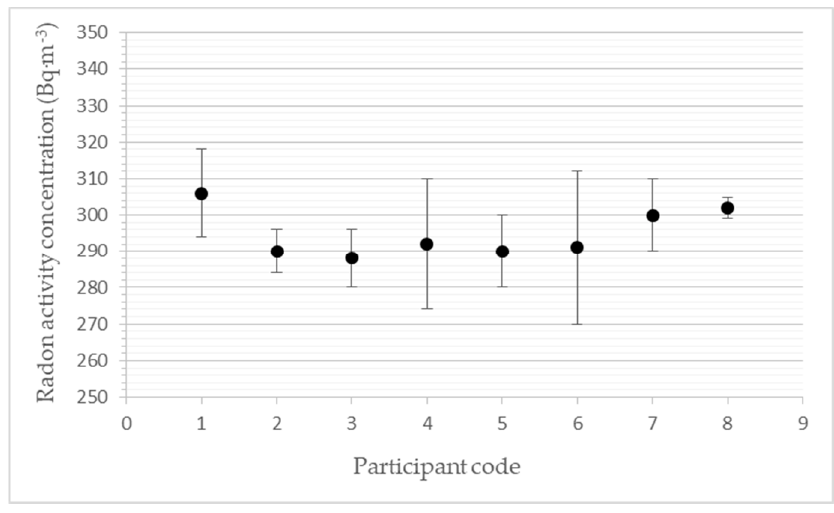
Figure 3. Participants’ results for a level of 300 Bq·m − 3.